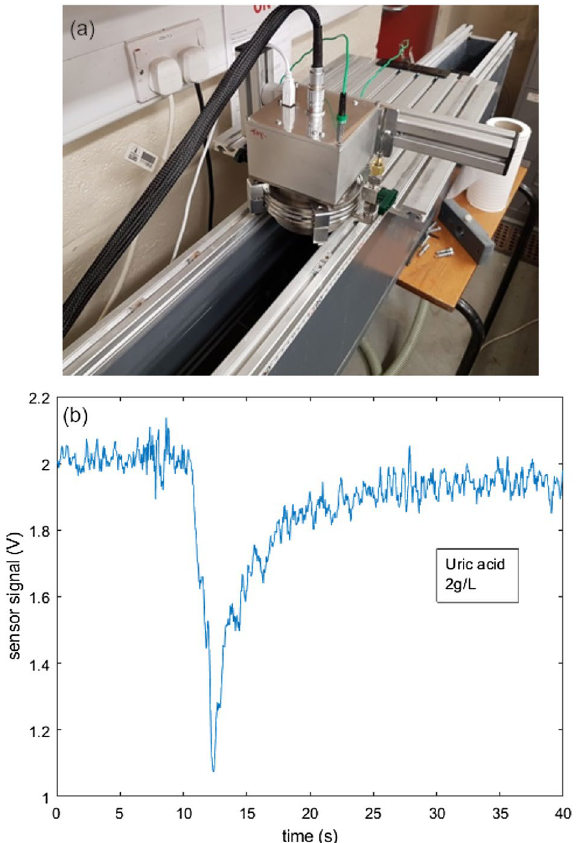
Figure 5. Photograph ( a ) of the sensor setup in a flume. The plot ( b ) shows a time series of sensor output. The pronounced dip at 10–12 s is due to arrival of uric acid solution deposited into the